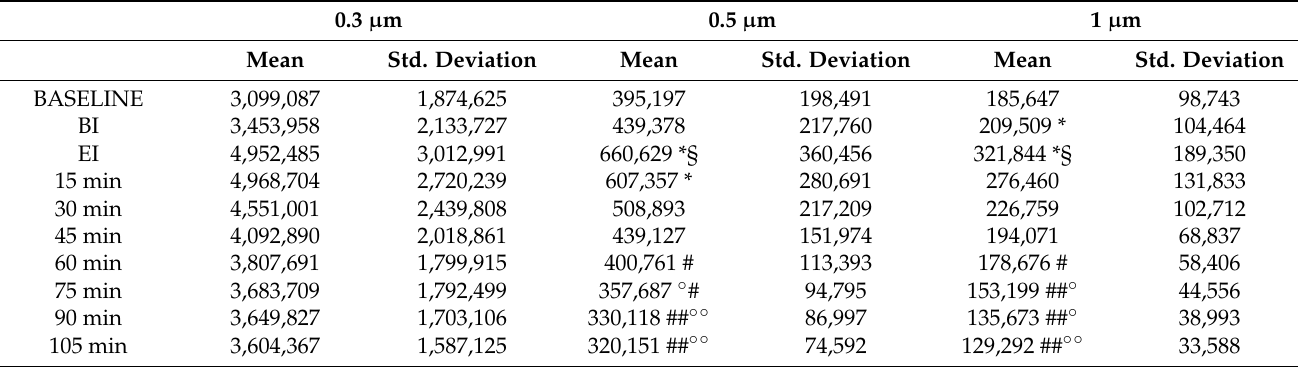
Table 1. Means and standard deviations of particles of submicron and micro aerosols throughout the study. Table legend. * p < 0.05 vs. baseline; § p < 0.05 vs. BI; # p < 0.05 vs. the end of instrumentation (EI) min; ## p < 0.01 vs. EI min; ◦ p < 0.05 vs. 15 min; ◦◦ p < 0.01 vs. 15